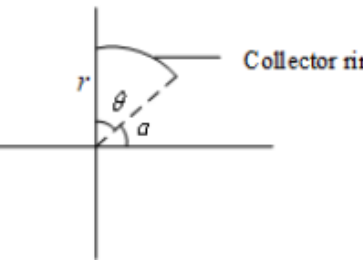
Figure 3. Geometric deconstruction of the confluence